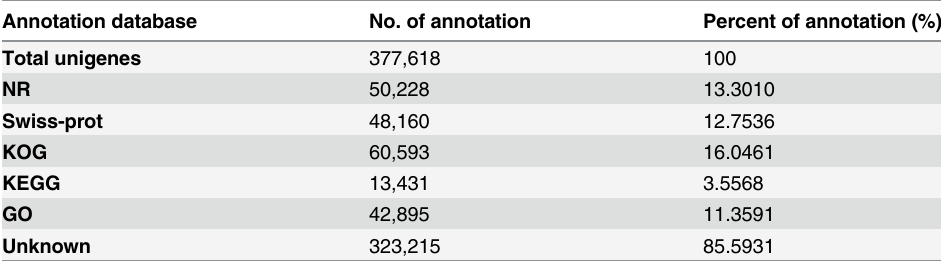
Table 3. All-in-one list of annotation.